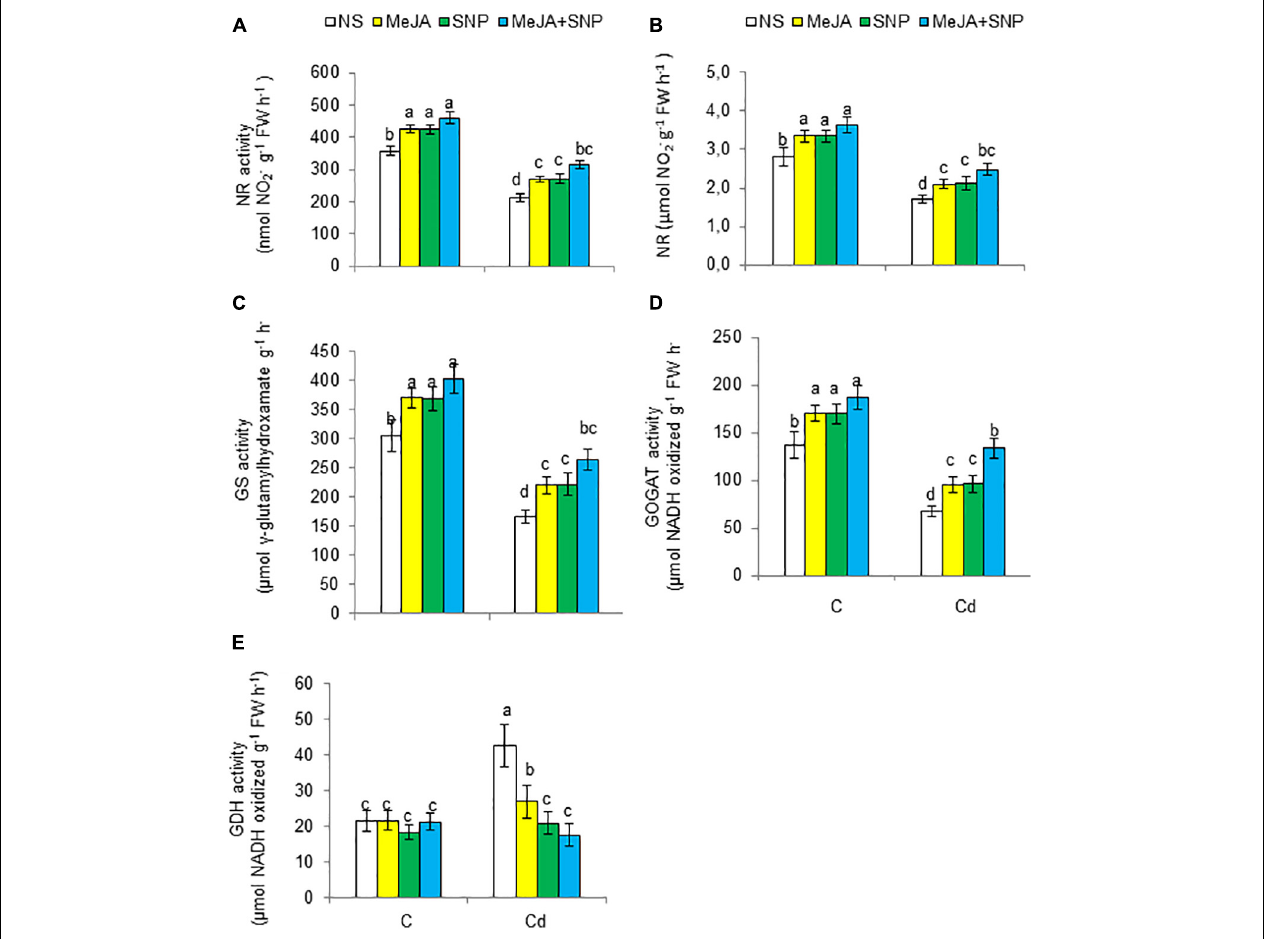
FIGURE 8 | Activities of nitrate reductase [NR (A) ], nitrite reductase [NiR (B) ], glutamine synthetase [GS (C) ], glutamate synthase [GOGAT (D) ], and glutamate dehydrogenase [GDH (E) ] on fresh weight (FW) basis in wheat plants grown under control (C) and cadmium (100 µ M Cd) and sprayed with 10 µ M methyl jasmonate (MeJA) or 100 µ M sodium nitroprusside (SNP) alone or together (mean ± SE). Mean values carrying different letters within each attribute differ significantly ( P ≤ 0.05) based on Duncan multiple-range